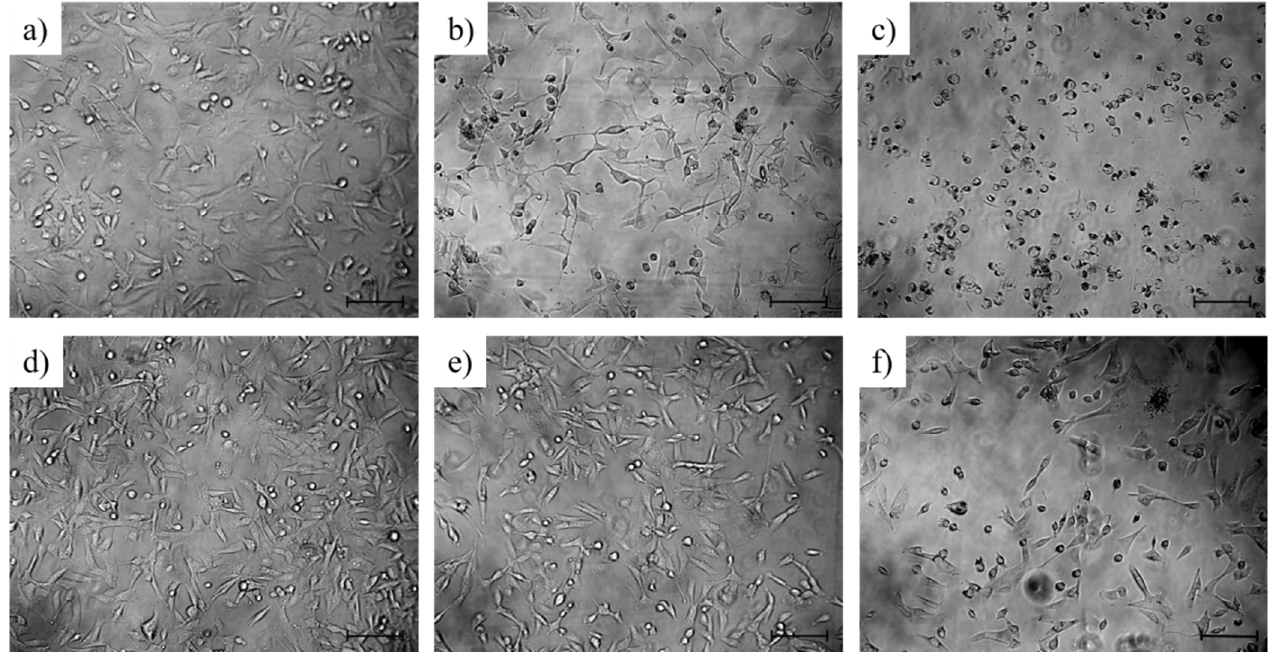
Figure 3. Phase-contrast microscopic morphology of MDA-MB-231 cells after 48 h-long treatment with free DOX ( a – c ) and FA 2 -dPEG-DOX 2 ( d – f ) at concentrations of 0.01 µM ( a , d ), 1 µM ( b , e ), and 100 µM ( c , f ) regarding DOX. The scale bars indicate 100 µm.